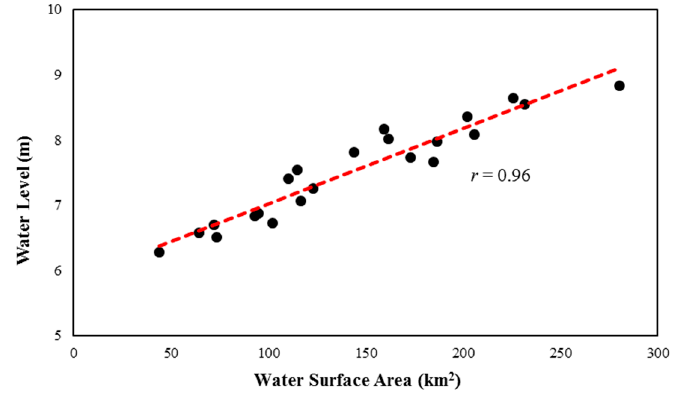
Figure 10. The relationship between the Baiyangdian Lake water area and water level.